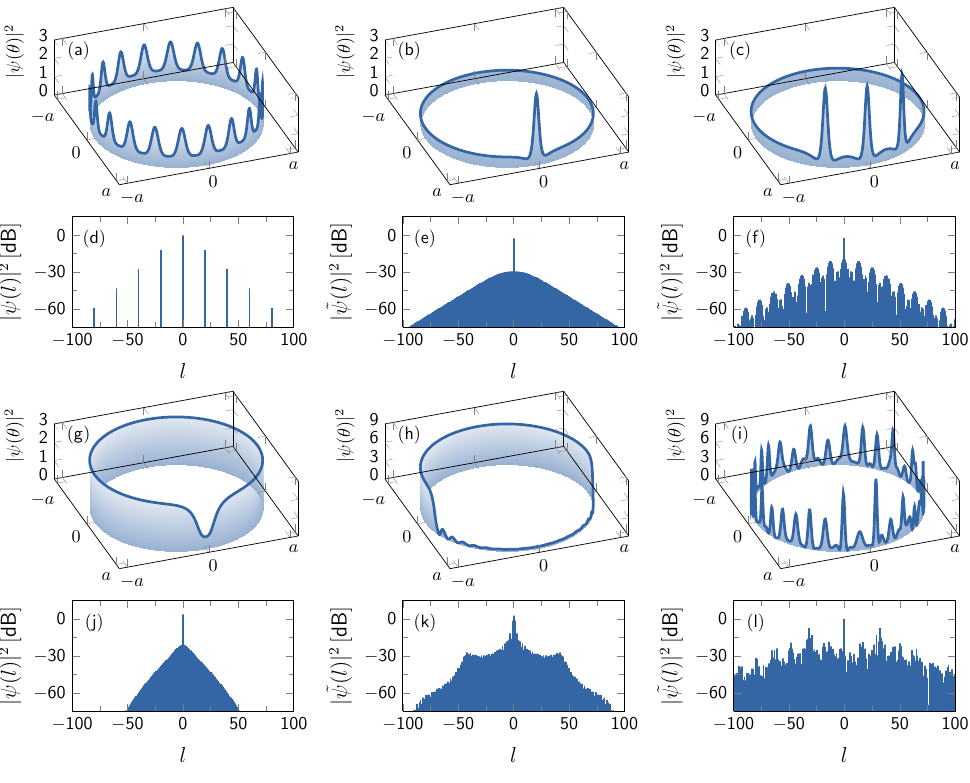
Figure 5: (Color online) Various spatiotemporal solutions and their corresponding spectra (Kerr combs), obtained after simulation of Eq. (3). The conditions under which these solutions can be excited are investigated in detail in ref. [18]. For all these simulations, we consider a CaF 2 resonator coupled in the add-through configuration, with a = 2.5 mm, λ L = 1550 nm, Q int = 4 Q ext = 10 9 , n g = 1.43 , g 0 = 2 π × 60 µ Hz, and a free-spectral range Ω FSR /2 π = 13.35 GHz. The absolute value of the GVD is set to | ζ 2 | = 2 π × 2.9 kHz for both anomalous and normal GVD. Note that the pumped mode is l = 0 , so that the sidemodes expand as l = ±1, ±2, . . . (a) and (d) Roll pattern of order L = 20 ( P = 2.5 mW and σ = − ∆ω tot /2 ). (b) and (e) Bright soliton ( P = 3.5 mW and σ = − ∆ω tot ). (c) and (f) Bright soliton molecule ( P = 3.5 mW and σ = − ∆ω tot ); (g) and (j): Dark soliton ( P = 5.3 mW and σ = −1.25 ∆ω tot ), (h) and (k): Platicon ( P = 17.3 mW and σ = −3 ∆ω tot ). (i) and (l): Chaos ( P = 15 mW and σ = − ∆ω tot /2